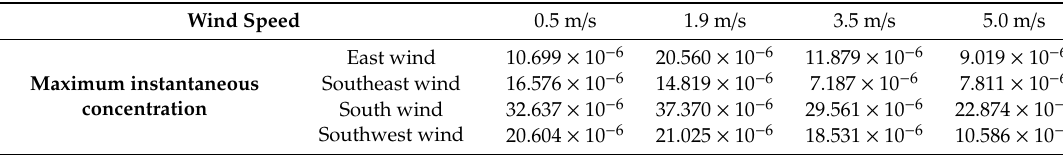
Table 2. Maximum instantaneous concentrations of harmful air around surrounding buildings under di ff erent wind